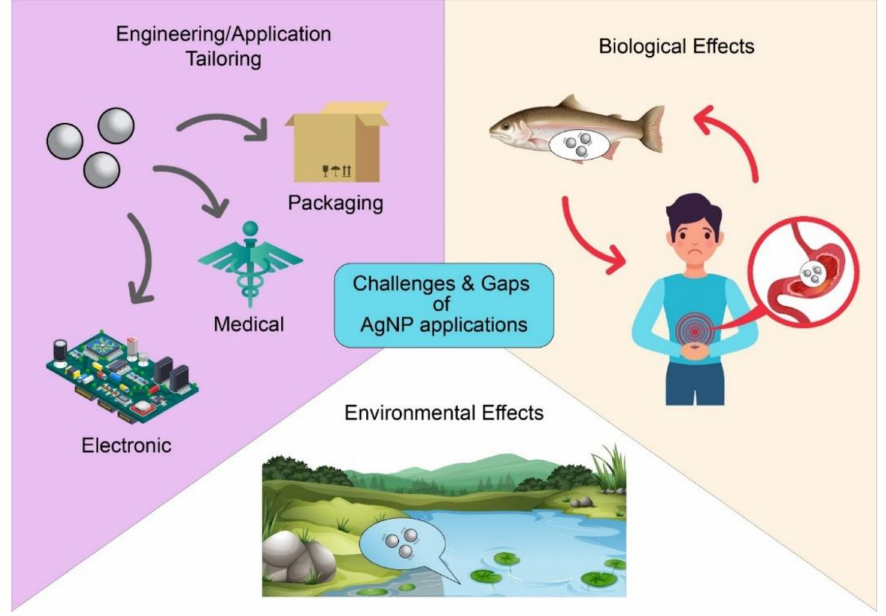
Figure 8. The challenges and gaps of AgNP